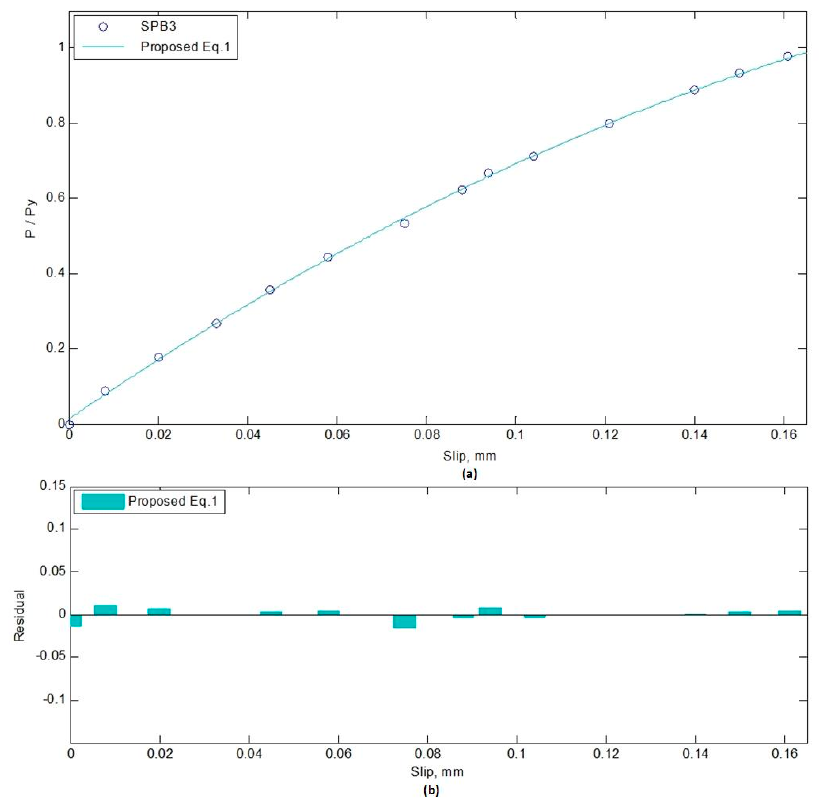
Figure 6. Fitting of curve, SPB3: ( a ) Load-slip; ( b ) Residual-slip.